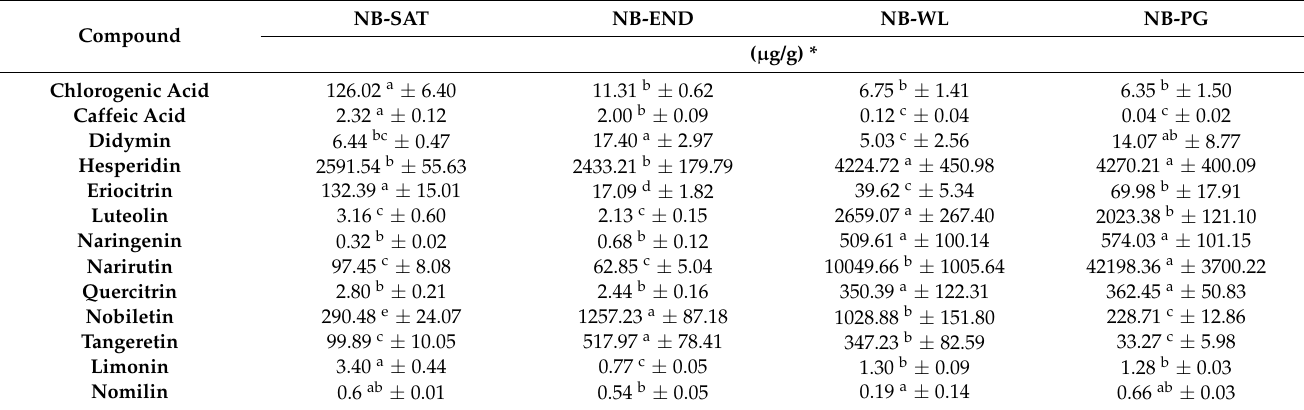
Table 3. Identified phytochemicals in non-bearing leaves of ‘Ellendale’ (NB-END), ‘Willowleaf’ (NB-WL), ‘Page’ (NB-PG), and ‘Satsuma’ (NB-SAT) and their concentration expressed in µ g/g of dried